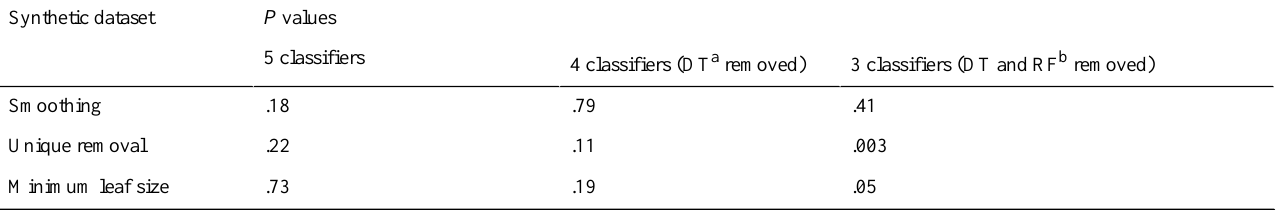
Table 10. Results of chi-square analysis of the difference in matching winning classifiers for models trained on real versus synthetic data with statistical disclosure control applied. P valuesSynthetic